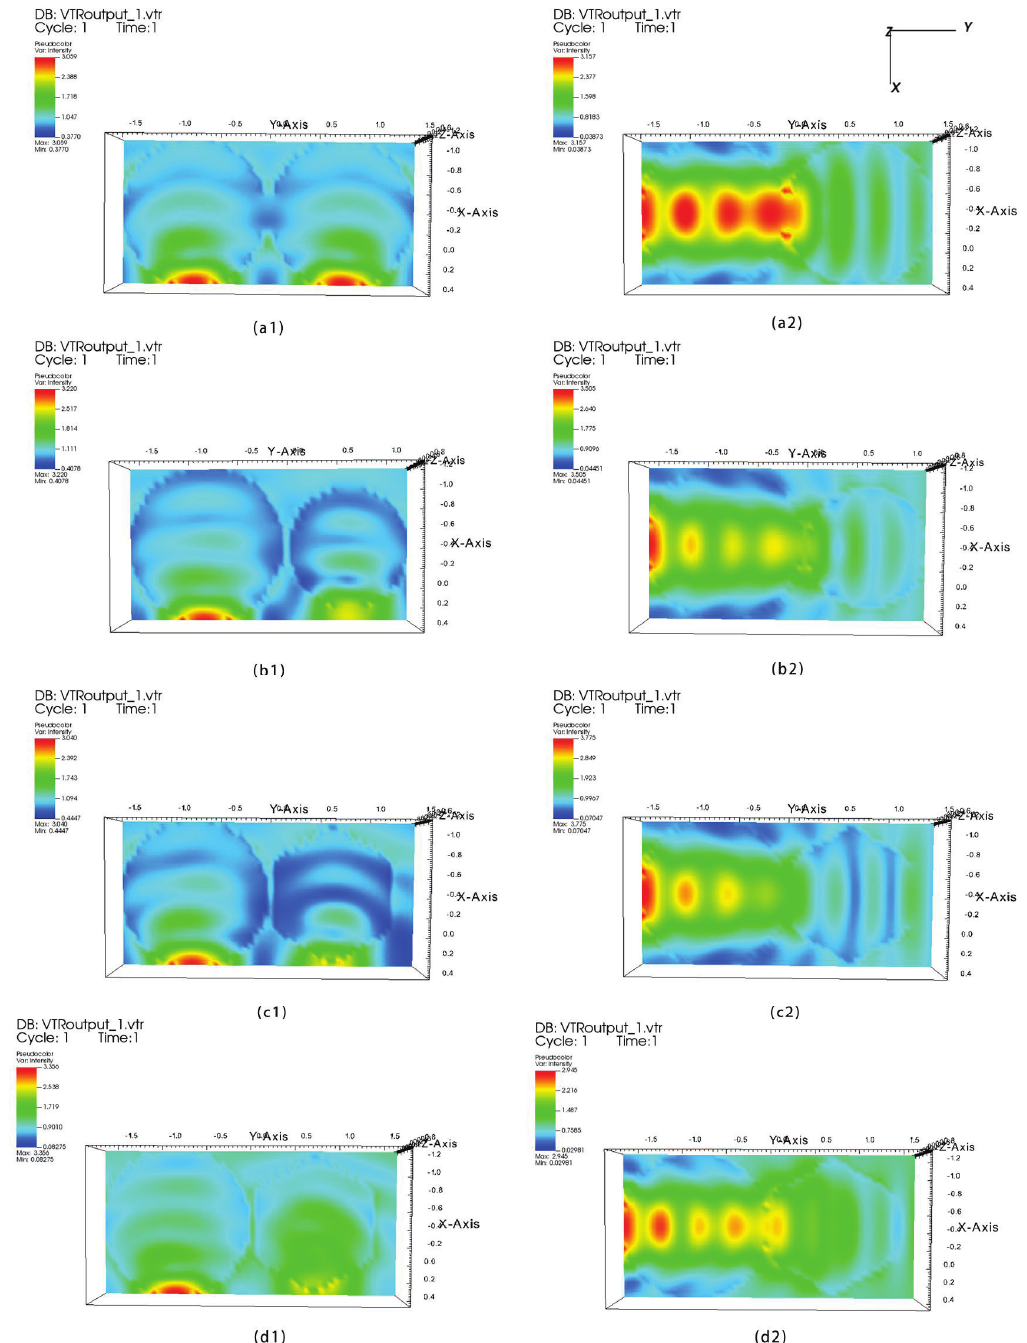
Figure 7. Visualization of the near-field electric field distribution of the four clustered particle models. ( a1 ) sphere–sphere Θ = 0 ◦ ; ( a2 ) sphere–sphere Θ = 90 ◦ ; ( b1 ) sphere–ellipsoid Θ = 0 ◦ ; ( b2 ) sphere– ellipsoid Θ = 90 ◦ ; ( c1 ) sphere-hexagonal prism Θ = 0 ◦ ; ( c2 ) sphere-hexagonal prism Θ = 90 ◦ ; ( d1 ) sphere-hexagonal plate Θ = 0 ◦ ; ( d2 ) sphere-hexagonal plate Θ = 90 ◦